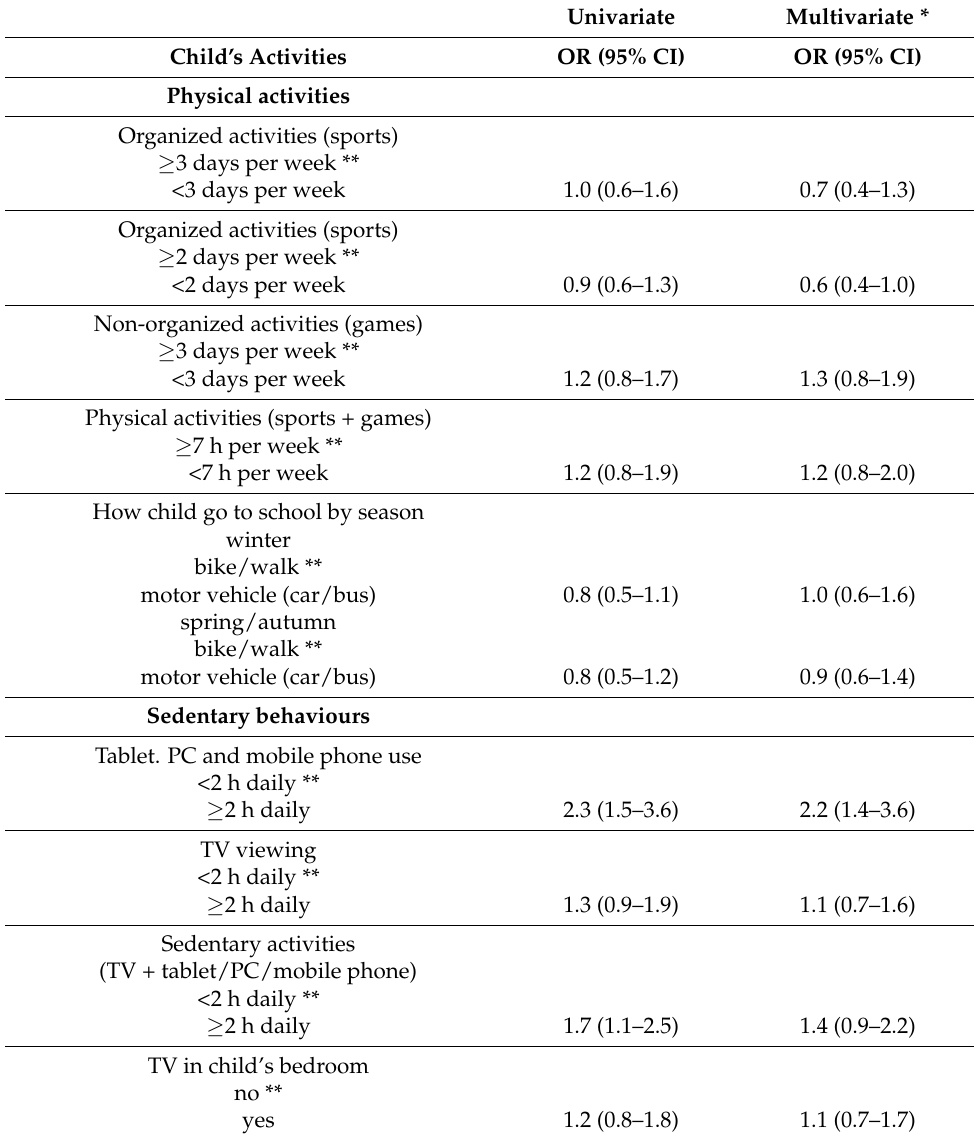
Table 4. Child’s activities and overweight/obese outcome: univariate and multivariate logistic regression